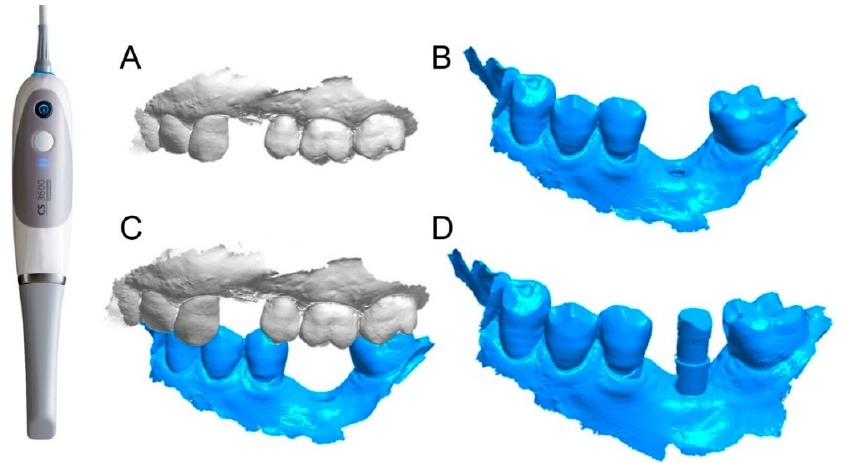
Figure 2. First intraoral scan (SCAN1) of the implant position (#36) with CS 3600 ® (Carestream Dental, Atlanta, GA, USA). ( A ) antagonist arch; ( B ) master model; ( C ) occlusion; ( D ) scanbody in position.